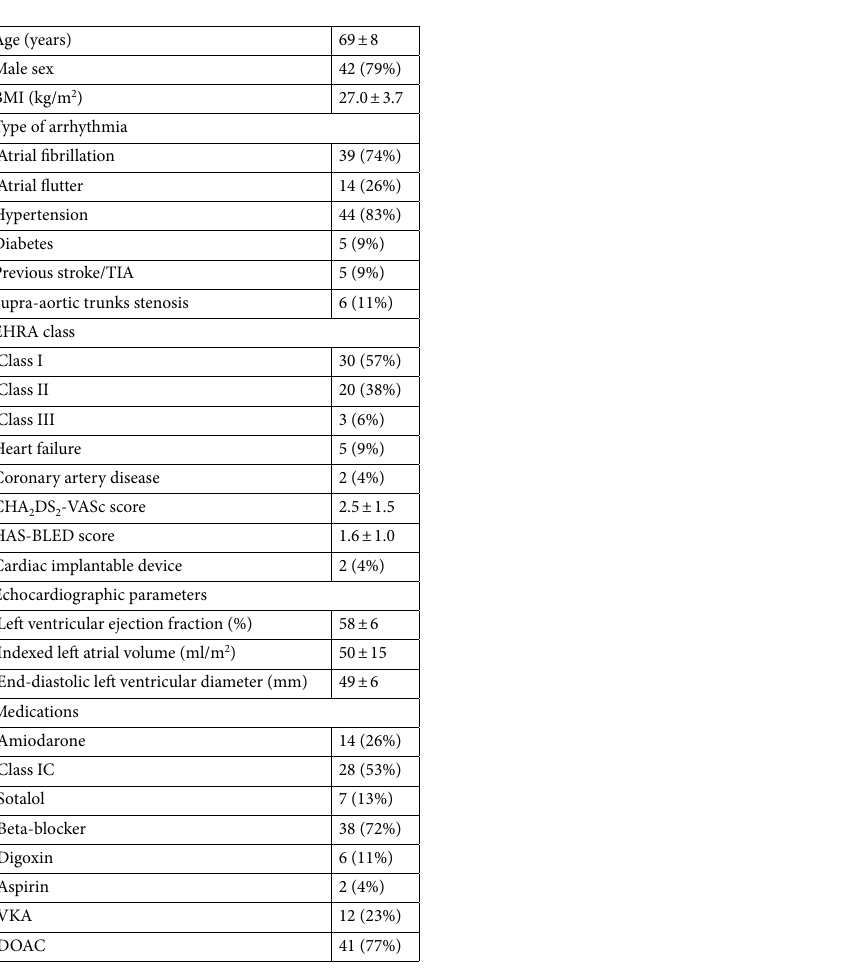
Table 1. Baseline characteristics of the enrolled patients (N = 53). BMI body mass index, DOAC direct oral anticoagulant, TIA transient ischemic attack, VKA vitamin K